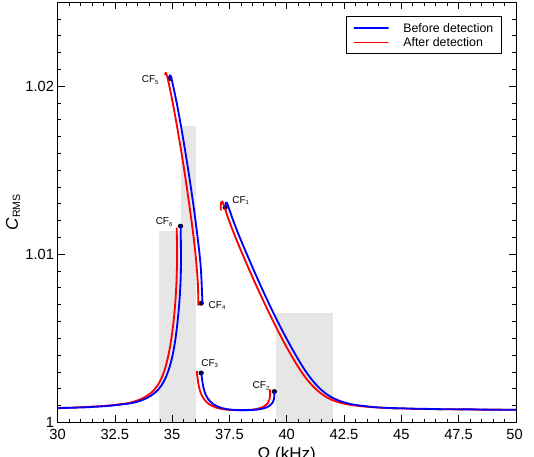
Figure 14. The normalized RMS capacitance for sensors made of an arch microbeam with an initial rise of w o = 6µm under the voltage waveform V DC = V AC = 12.2V.